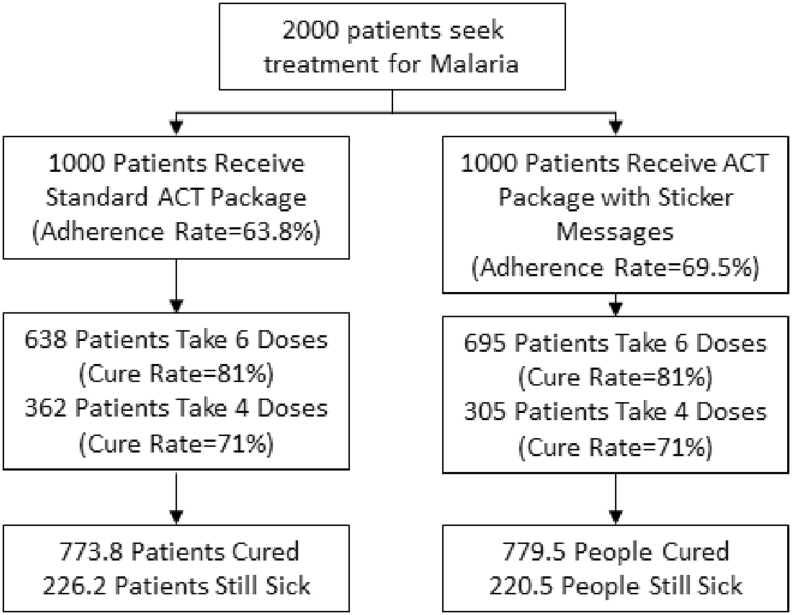
Estimates of number and cost of averted infections with the sticker interventions. We assume that patients who receive the targeted messages on the stickers have an adherence rate of 69.5% while patients who receive the standard ACT package have an adherence rate of 63.8% (see Table 2, Column 4). Patients who do not adhere are assumed to take 4 doses of the medication instead of the recommended 6 doses. Cure rates are from Vugt et al. (1999) and are not PCR-corrected to distinguish new from recurrent infection.